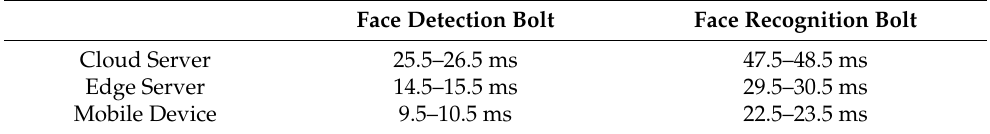
Table 3. Latency ranges for